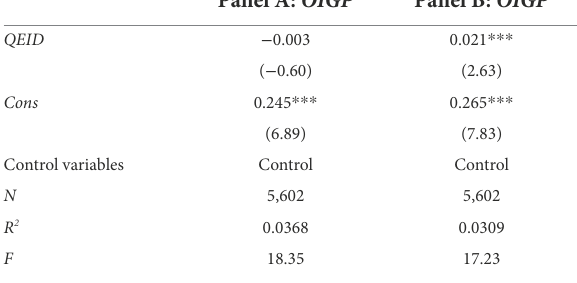
TABLE 11 Robustness test results. Panel A: OIGP Panel B: